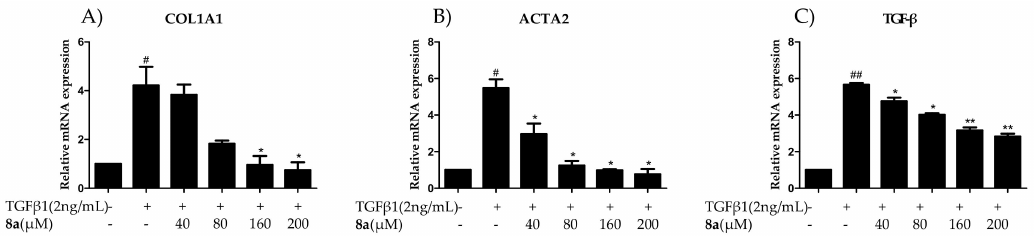
Figure 4. E ff ects of compounds 8a on inhibiting COL1A1 (A), ACTA2 (B), and TGF β (C) mRNA levels in LX-2 cells after a 24-h treatment at the concentrations of 40, 80, 160 and 200 µ M. The data were analyzed by the real-time PCR and presented as the mean ± SEM, (#) p < 0.05 as compared to that of the control group; (*) p < 0.05, (**) p < 0.01 as compared to that of TGF- β 1 group. The mRNA expression levels were normalized against